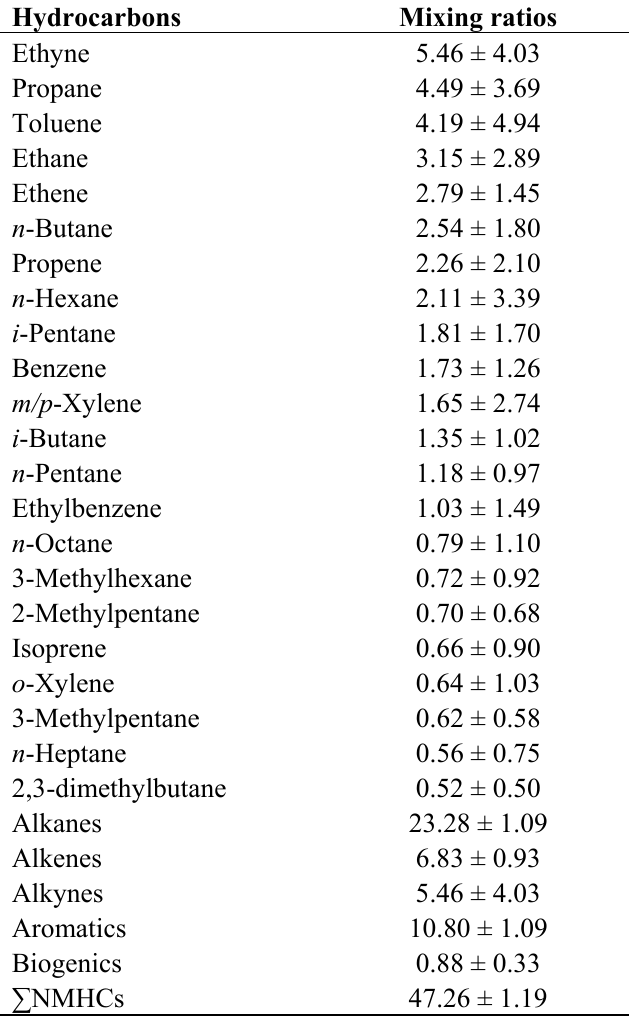
Table 1. Mixing ratios of abundant hydrocarbons at an urban site in Guangzhou (units: